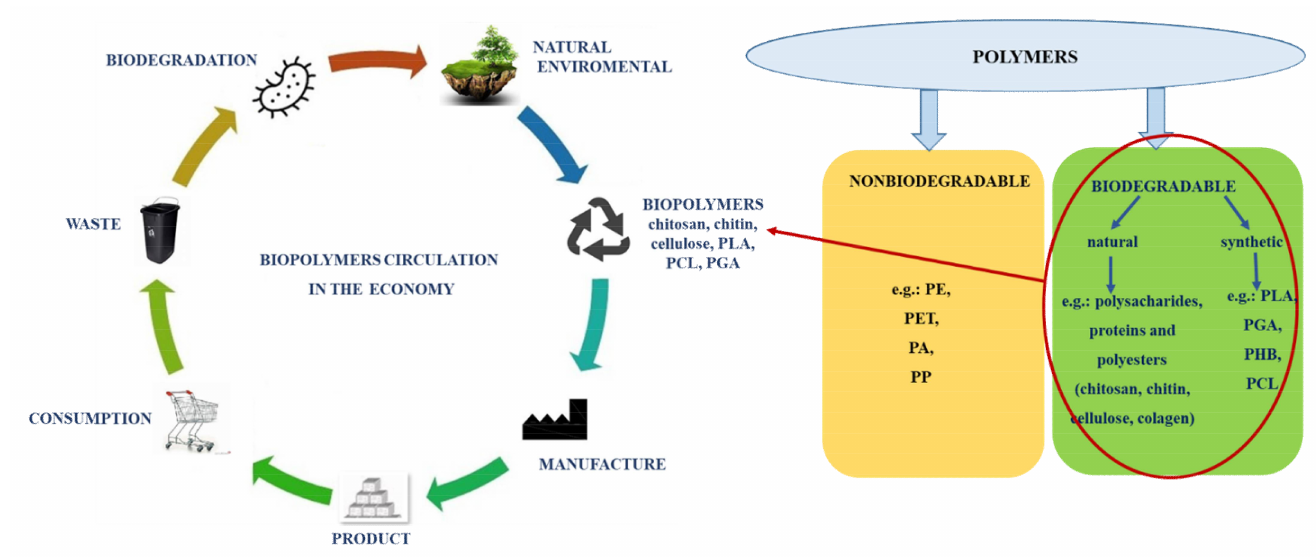
Figure 2. Life cycle of biodegradable polymers within the context of circular